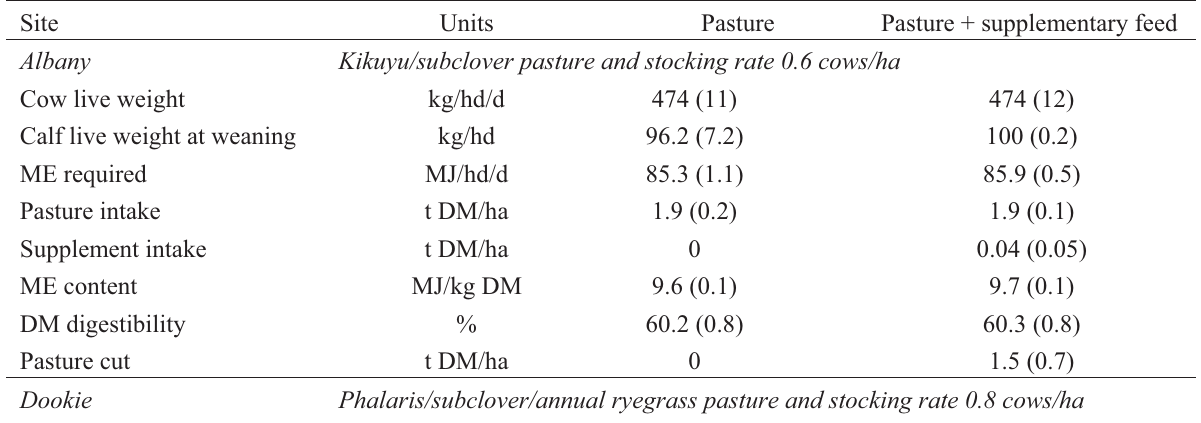
Table 2. Mean (s.d) annual predicted cow live weight and their offspring, total metabolizable energy (ME) requirement, the quality of the diet consumed (ME content and digestibility) and surplus dry matter (DM) cut for beef cow-calf 1 grazing systems at Albany, Dookie, Vasey and Wagga Wagga between the years 1971 to 2000 on pasture or a pasture and supplementary feed 2